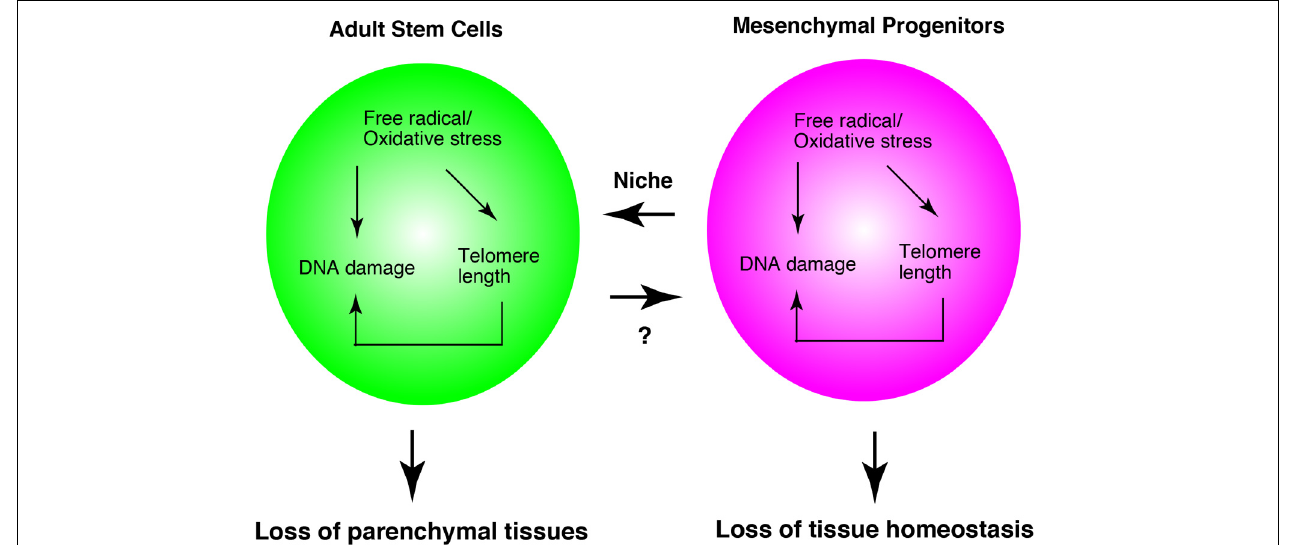
FIGURE 3 | Adult stem cell and mesenchymal progenitor theories of aging. Interrelationship of three theories in adult stem cells and mesenchymal progenitors. Mesenchymal progenitors serve as the niche cells for hematopoietic stem cells. In skeletal muscle, mesenchymal